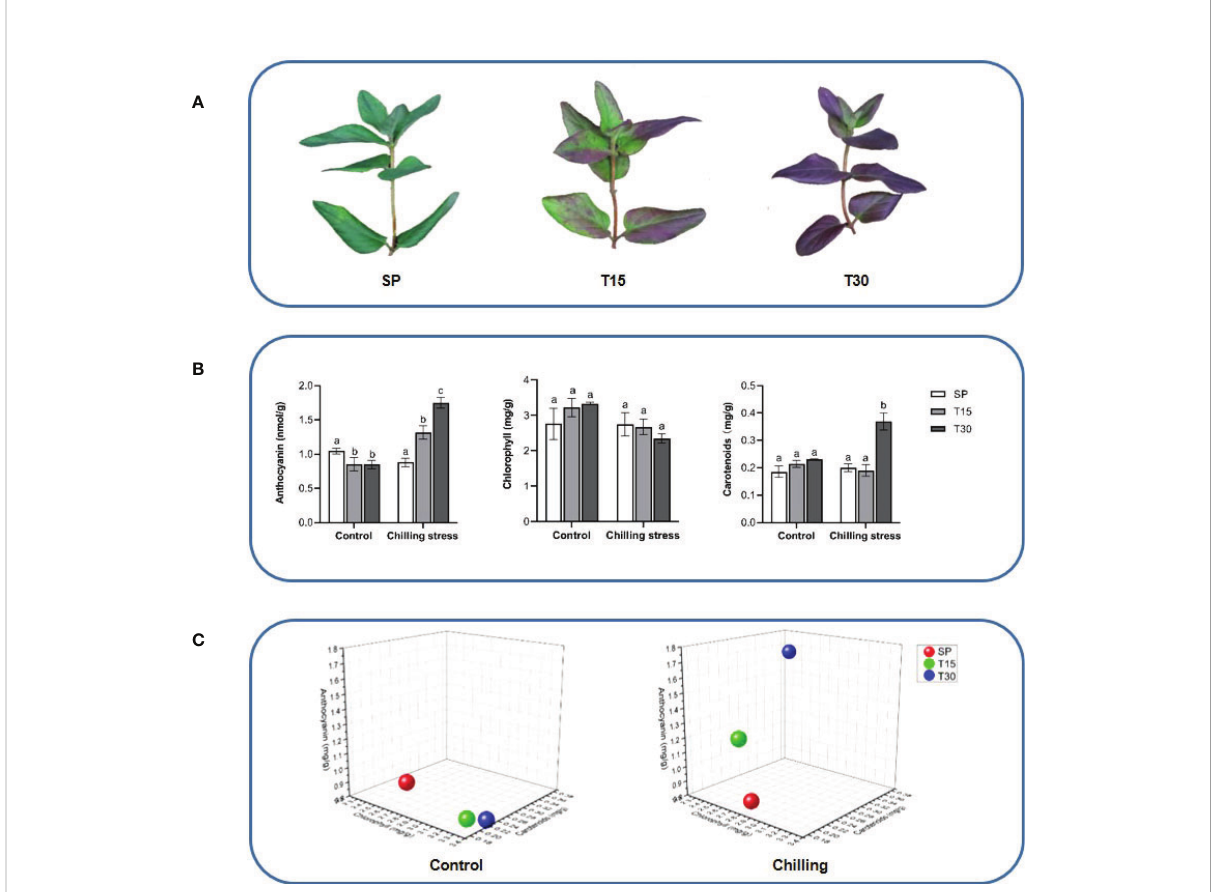
FIGURE 1 Morphological observation and pigment content of the leaves of L. japonica. (A) Phenotypic changes of leaves under chilling stress; (B) Pigments content analysis; (C) 3D coordinate map. The location of spheres in the maps represents the ratio of contents of chlorophylls, carotenoids, and anthocyanins in leaves of L. japonica . Means with the same letter were not signi fi cantly different among samples while different letters indicate that the change is signi fi cant according to one-way ANOVA test (p<